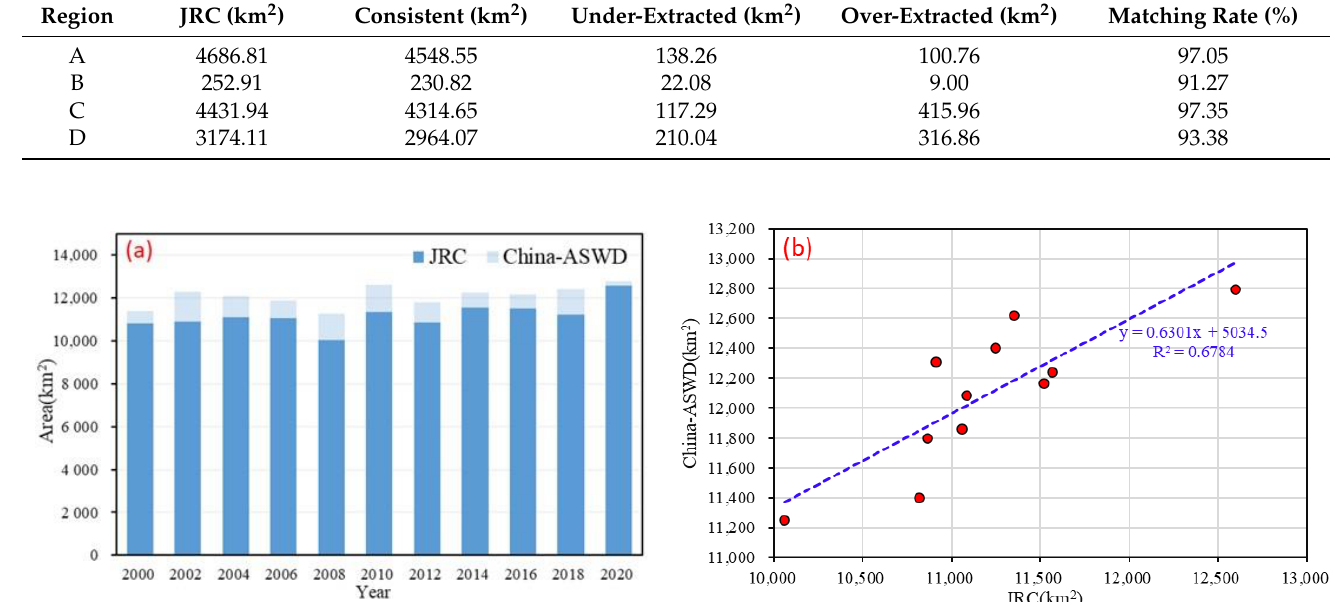
Figure 4. Time series comparison ( a ) and linear fitting result ( b ) of China-ASWD and JRC water body Table 1. Spatial comparison of China-ASWD compared to JRC water body data in 2019 for regions A, B, C and D.